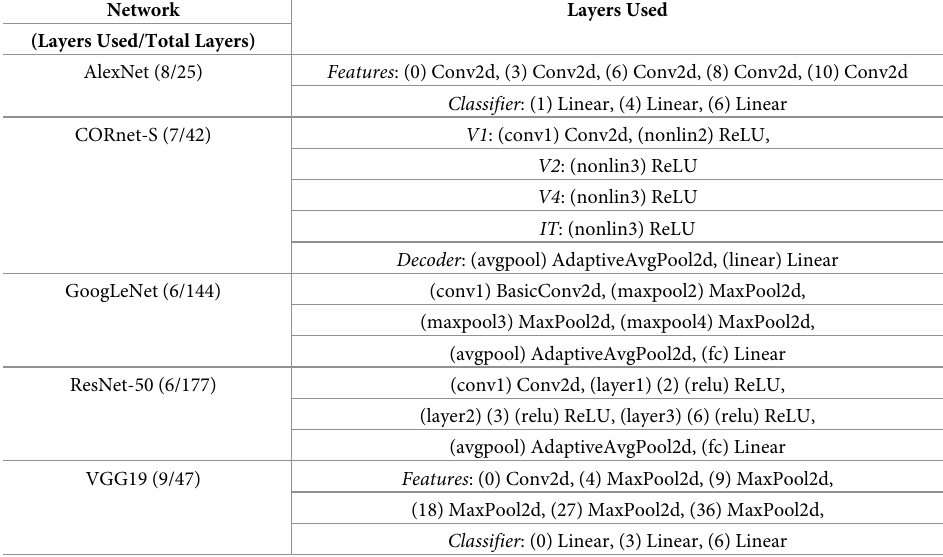
Table 1. The five CNNs included in the present study and the layers sampled in each CNN (PyTorch labels given).